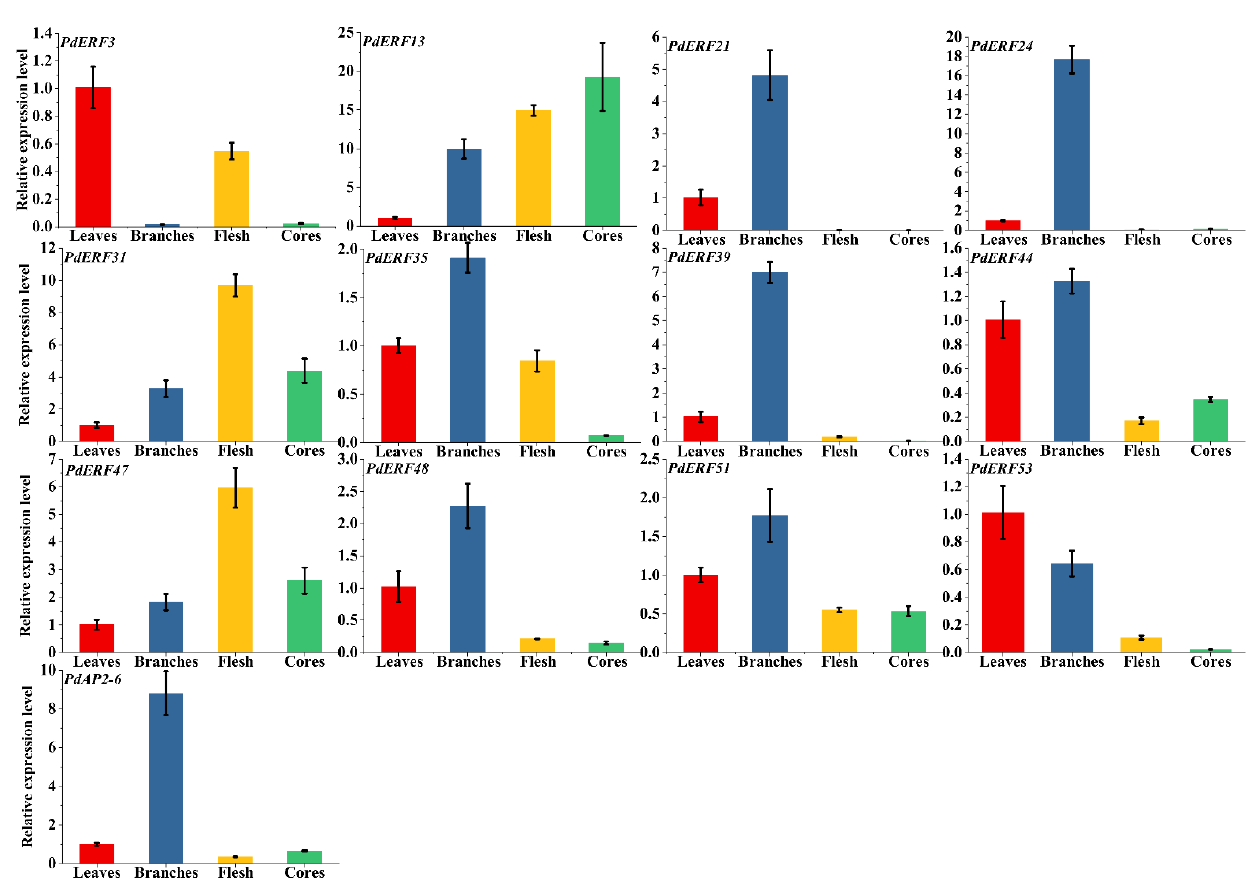
Figure 8. Fluorescence quantitative relative expression of 13 representative PdAP2/ERF genes in leaves, branches, flesh, and cores of ‘Wanfeng’ almond. The ordinate represents the relative expression level of genes, and the abscissa represents leaves, branches, flesh, and cores from left to right. treated with freezing stress at six temperatures were measured by qRT–PCR (Figure